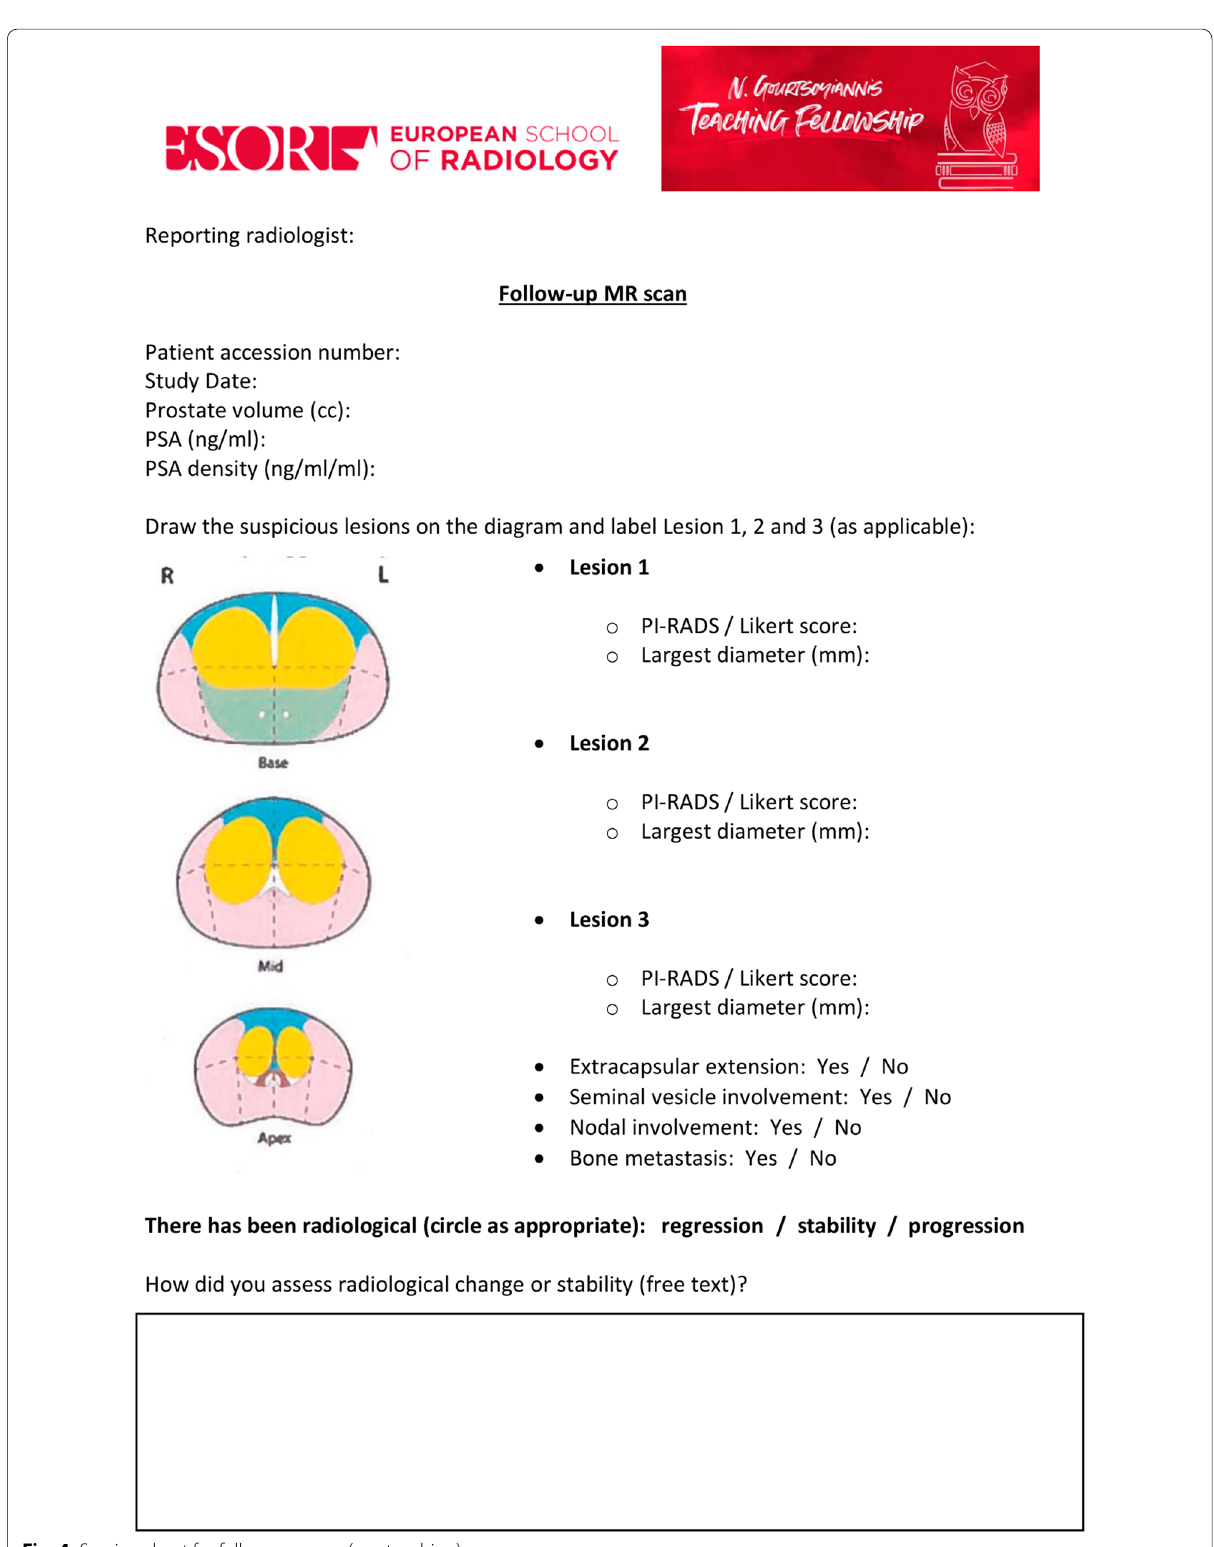
Fig. 4 Scoring sheet for follow‑up scans